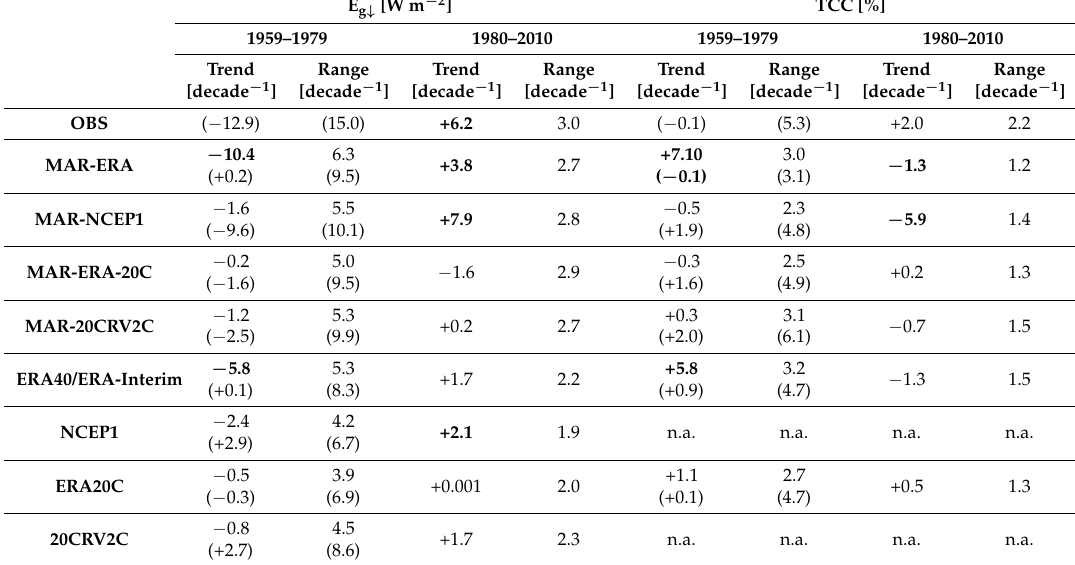
Table 2. Trends and their Snedecor uncertainty range for the 95% confidence interval computed for 1959–1979 (dimming period) and 1980–2010 (brightening period) for Saint-Hubert. The values in bold indicate that the trends are statistically significant at the 95% confidence level, namely that they are larger than the associated uncertainty range. The values between brackets indicate that they are computed for